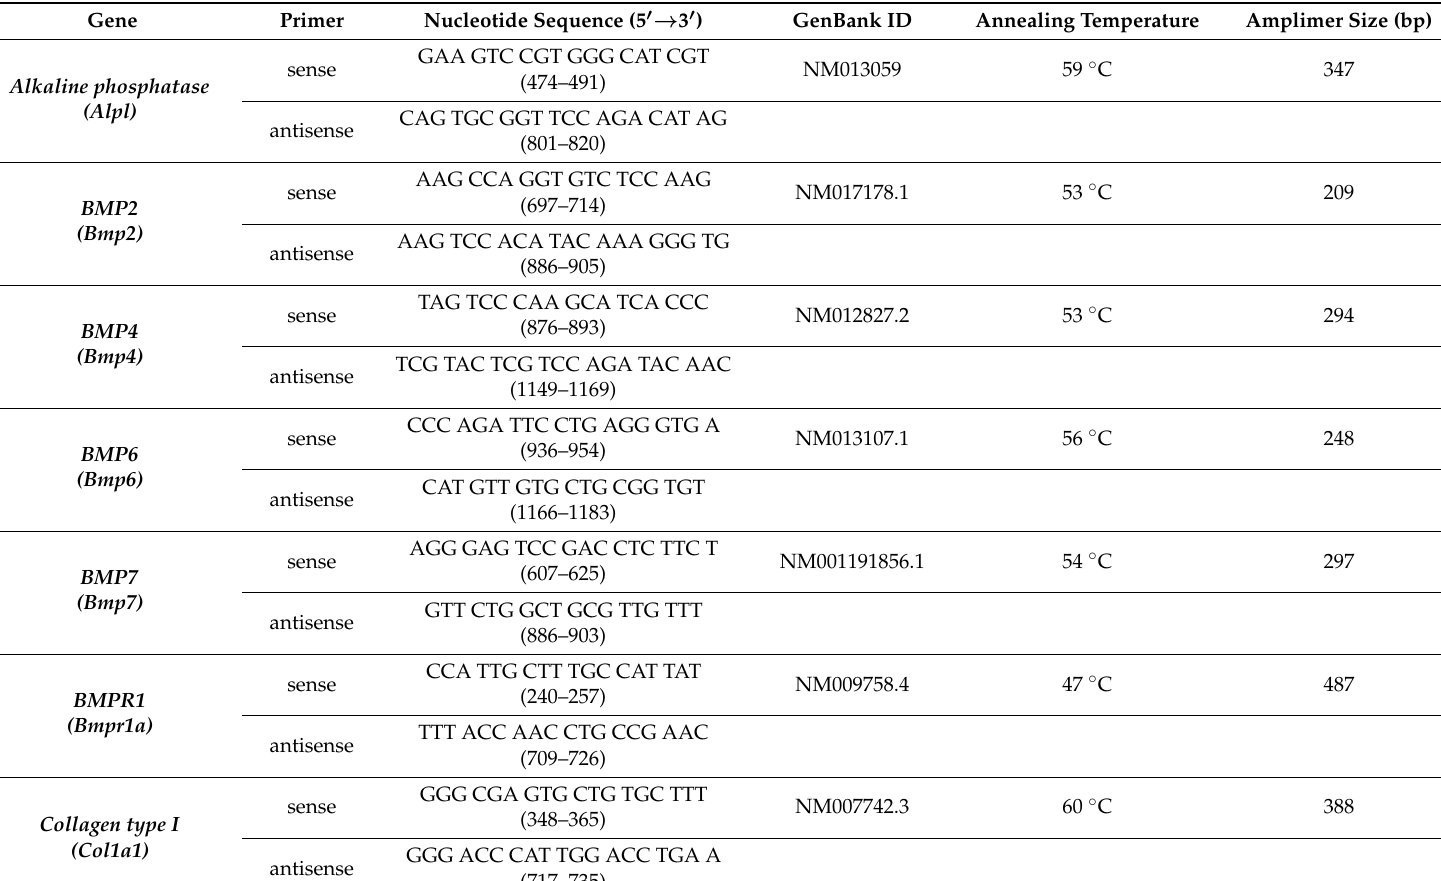
Table 1. Nucleotide sequences, amplification sites, GenBank accession numbers, amplimer sizes and PCR reaction conditions for each primer pair are